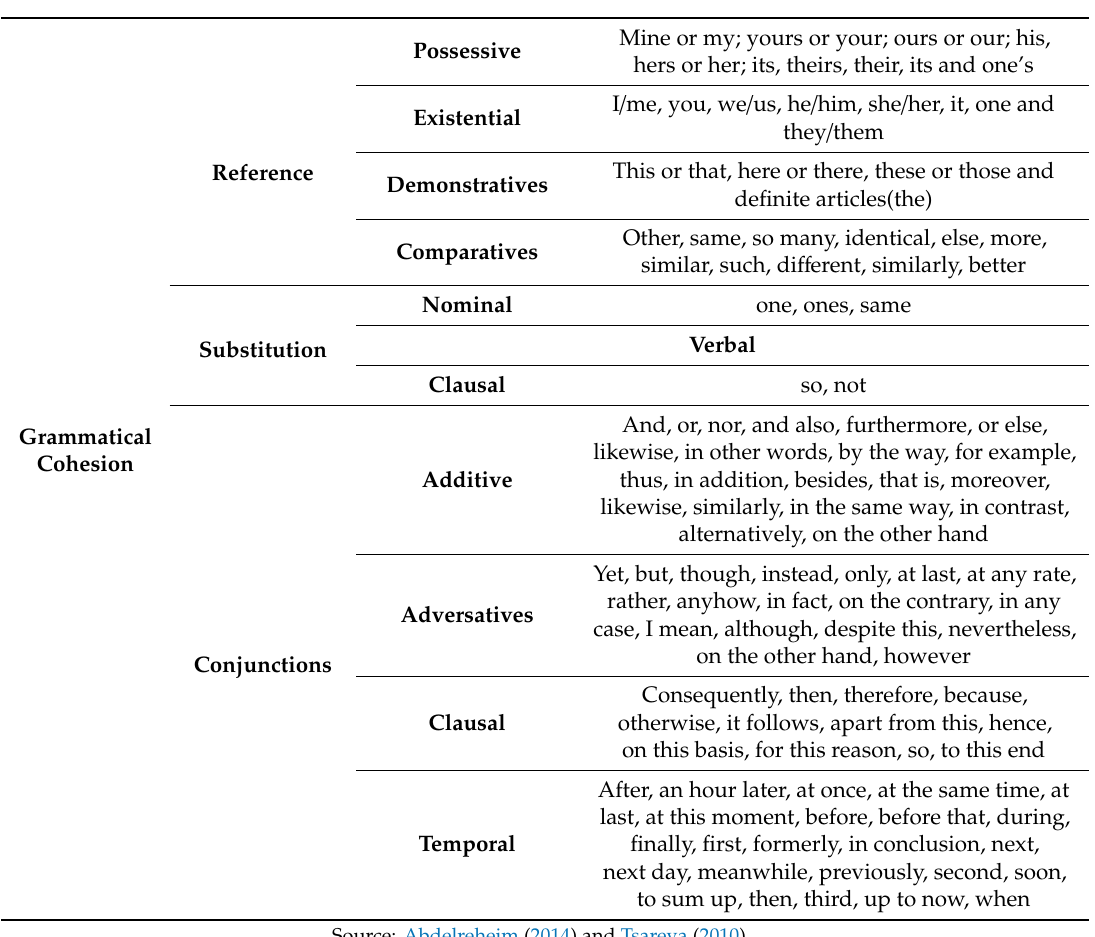
Table 2. Categories of grammatical